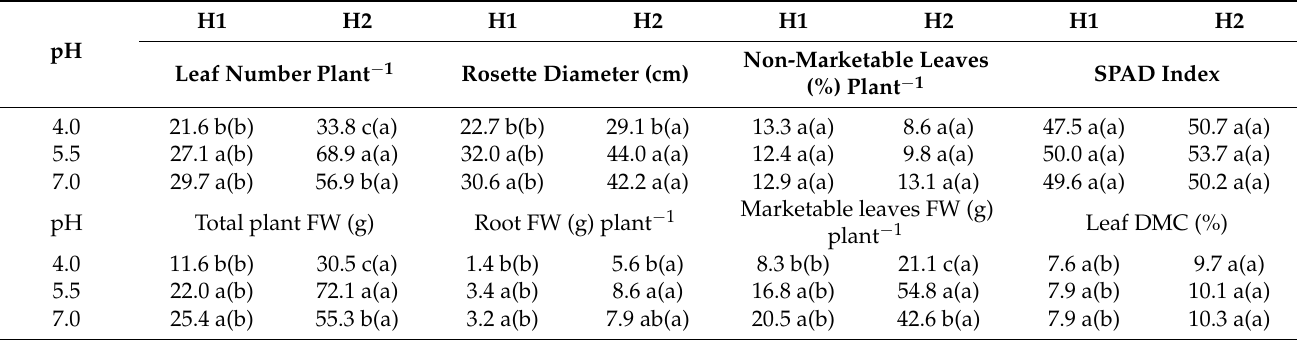
Means in columns followed by the same letter do not differ significantly ( p ≤ 0.05, L.S.D. test). Means in the same row followed by the same letter in parenthesis do not differ significantly ( p ≤ 0.05, T -test). FW: fresh weight; DMC: dry matter content.